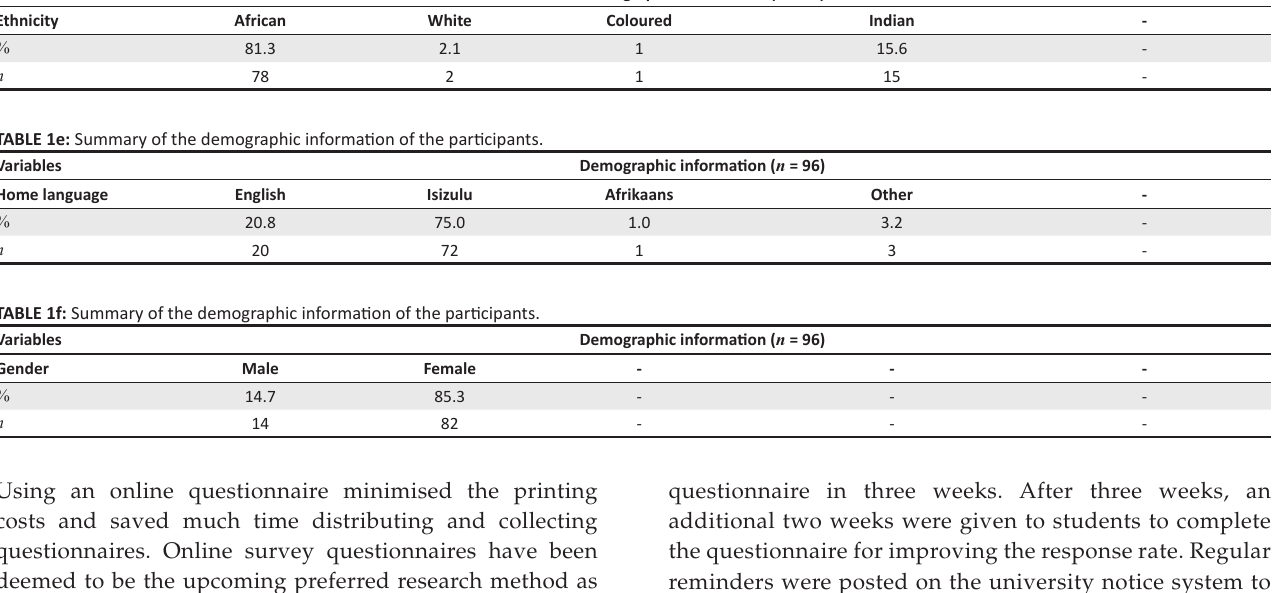
TABLE 1d: Summary of the demographic information of the participants. Variables